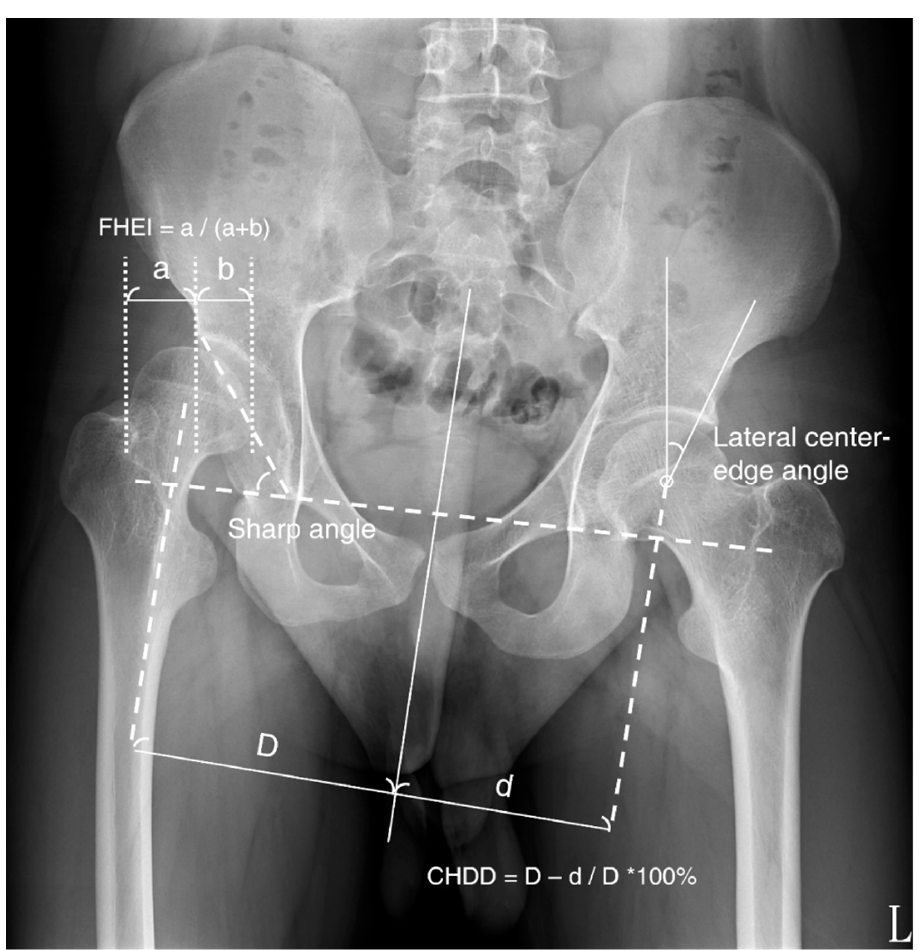
Figure 1. Radiographic outcome parameters on AP standing radiographs of the pelvis. FHEI: femoral-head extrusion index, CHDD: centre-head distance discrepancy.